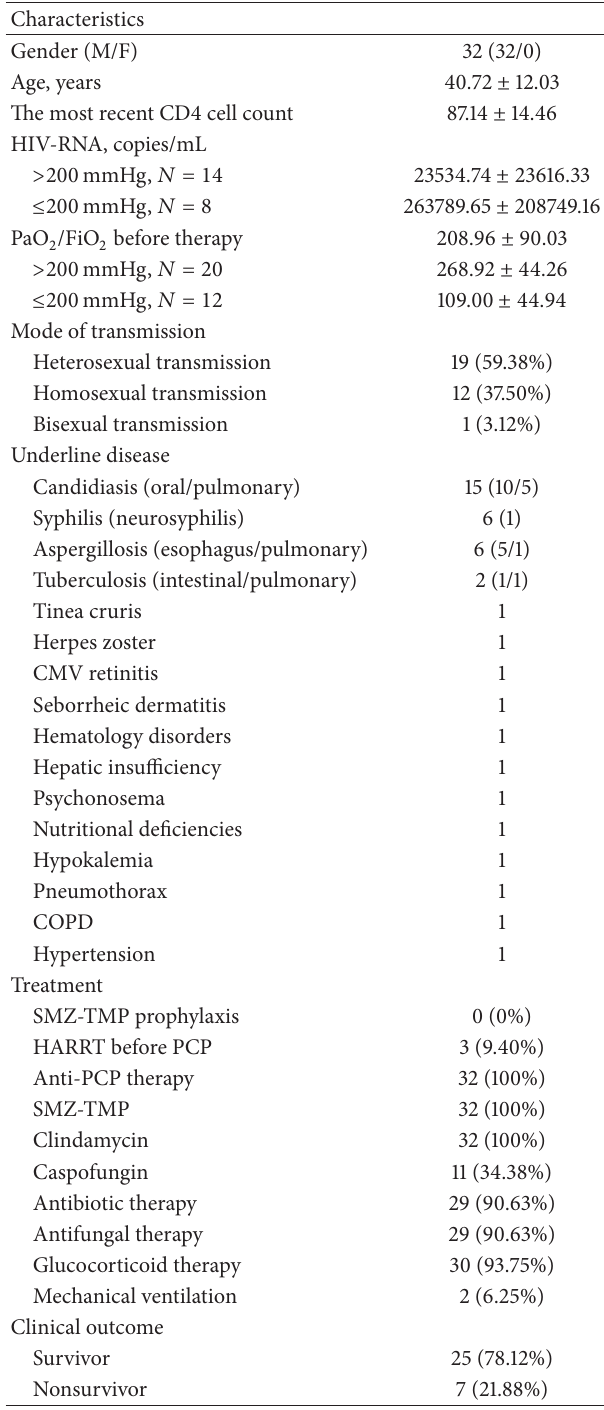
Table 1: Clinical characteristics and baseline demographics of AIDS PCP